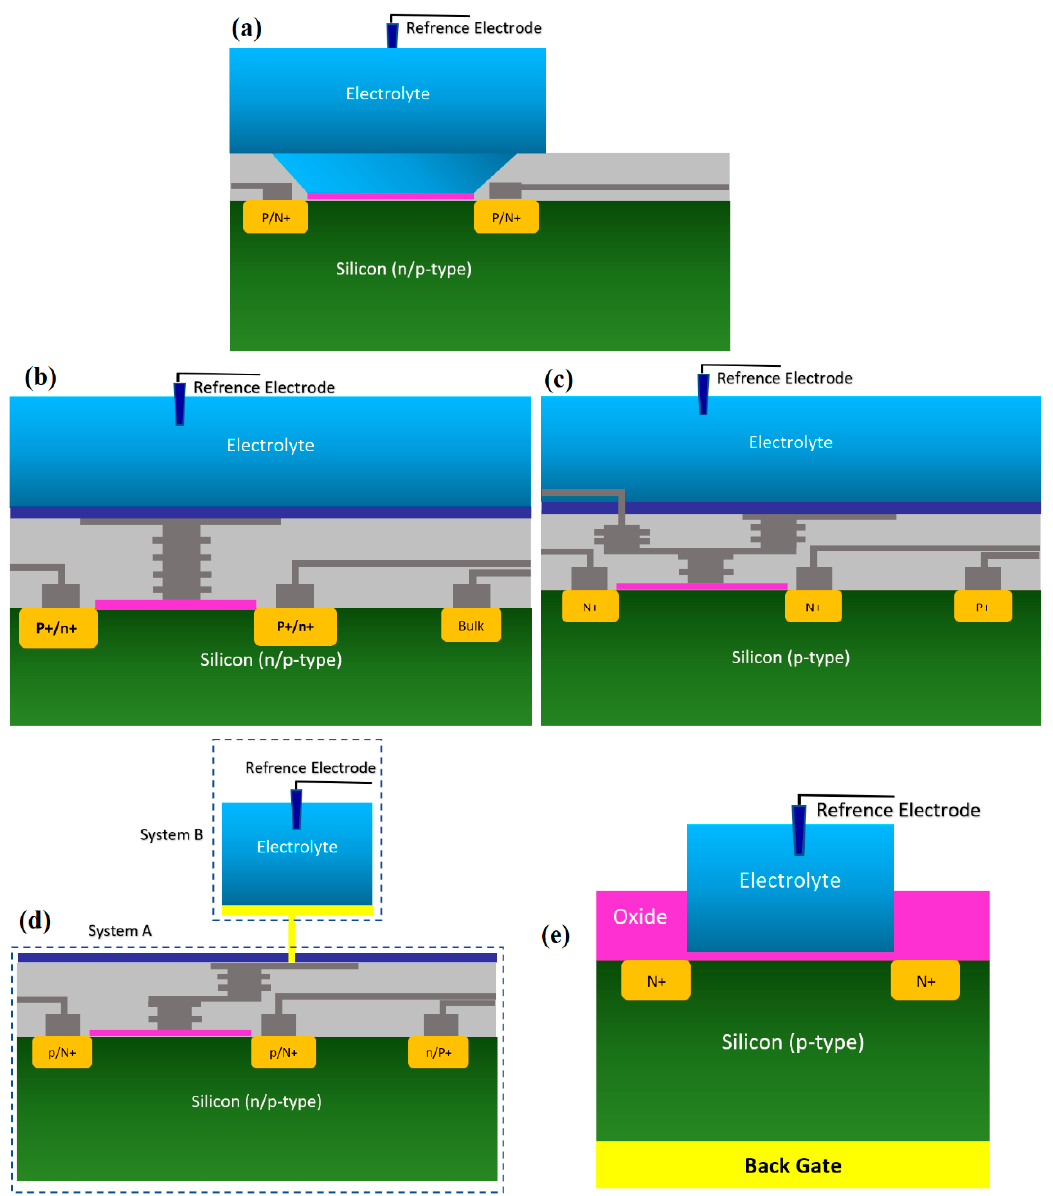
Figure 3. All structures of metal-oxide-semiconductor (MOS)-based ion-sensitive field-effect transistors (ISFETs) platforms that have been used for Chem/BioFET applications: ( a ) Representation of Oxide-electrolyte gate Chem/BioFETs, which include a reference in a solution on top of the oxide layer; ( b ) showing the floating gate structure by which the solution area has been separated from the conduction channel by an internal connection from the oxide layer on top of the channel to the solution and sensing membrane; ( c ) a demonstration of the integration of a floating gate with control gate, which helps to have more accurate control over the gate operation; ( d ) shows extended gate structure that allows us to have a bigger sensing area for biosensing purposes. Moreover, an extended gate creates enough room for further integration with the microfluidic system, which in most cases was not applicable to add them to small ISFETs; ( e ) oxide-electrolyte gate Chem/BioFET with the back gate in which used the back gate in order to manipulate the working point of the sensor by changing the depletion effects in the conductive channel.